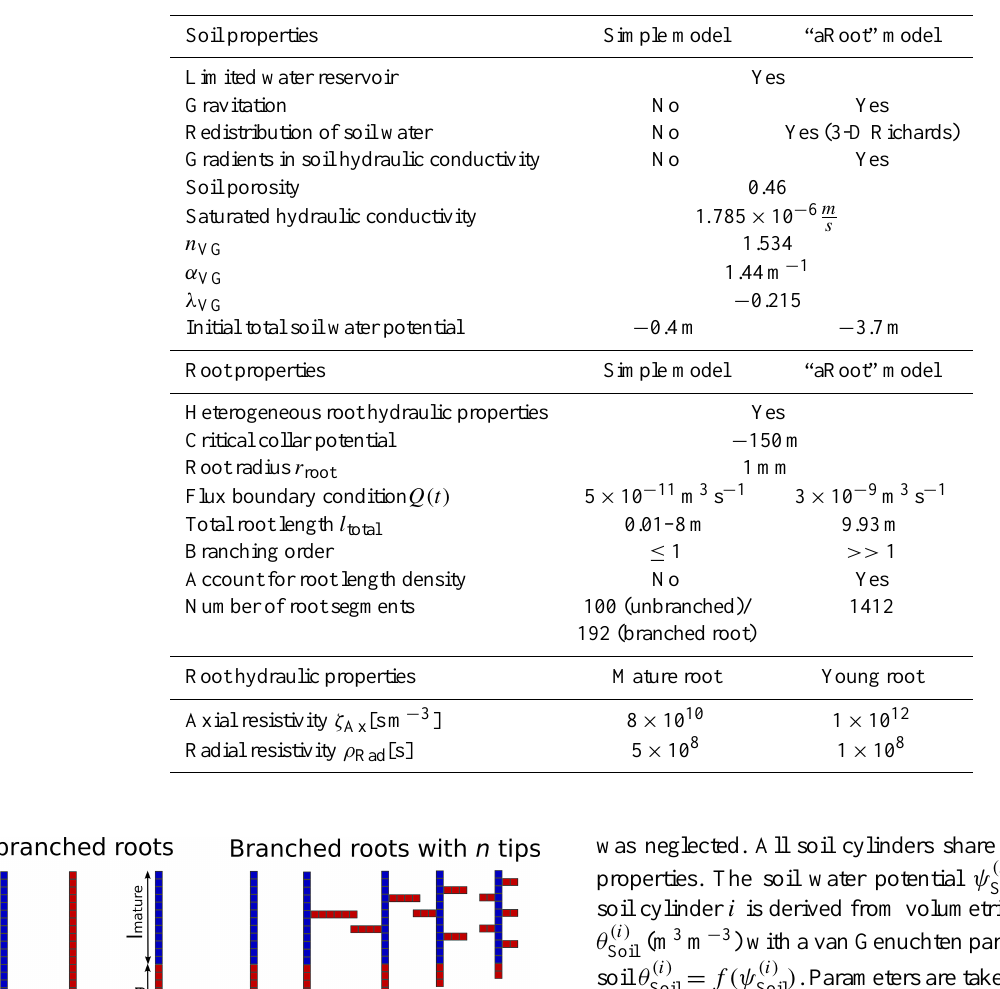
Table 1. Parameters and important features of the simple and the “aRoot” model.